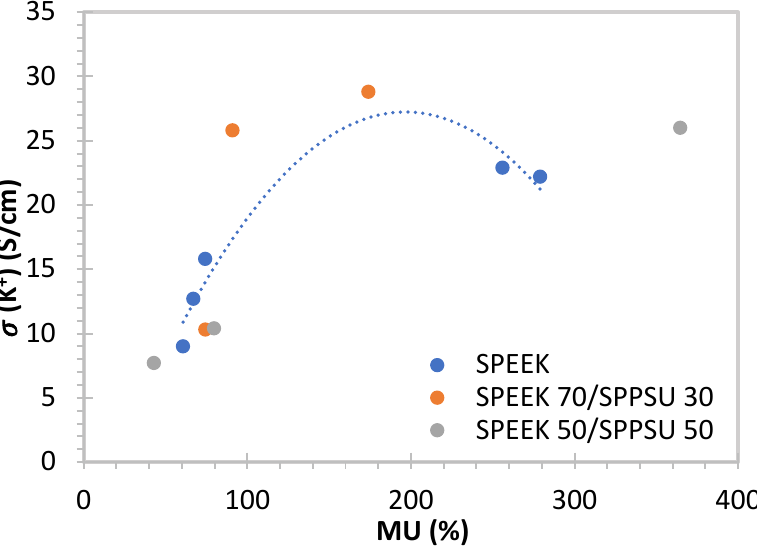
Figure 6. K + ion conductivity as a function of the mass uptake. The dotted line is a guide for the eye only.